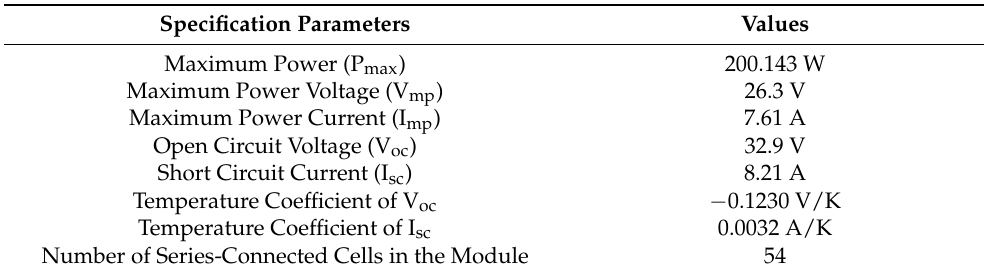
Table 1. Specifications for a KyoceraKC200GT 200 W panel (electrical performance under Standard Test Conditions